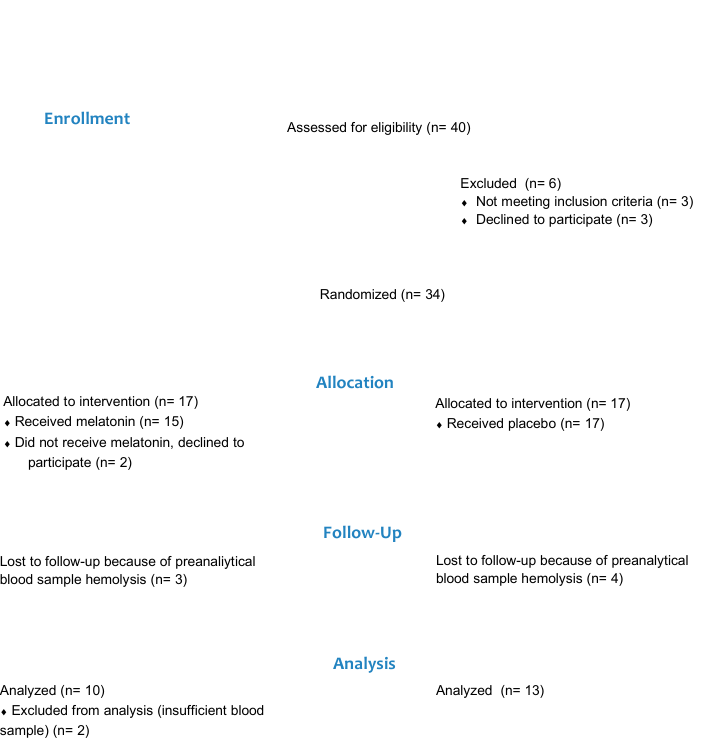
Figure 1. Flow of Figure 1. Flow of participants.